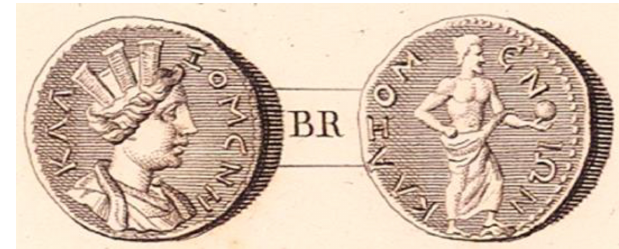
Figure 6. (Anaxagoras of Clazome- nae; c. 500–c. 428BC), the philosopher who transplanted the Ionian philosophy to Athens, depicted in the back facet of a coin whose front facet shows a ribbed head of a woman representing the per- sonified city of Clazomenae (image source: Visconti, 1817).